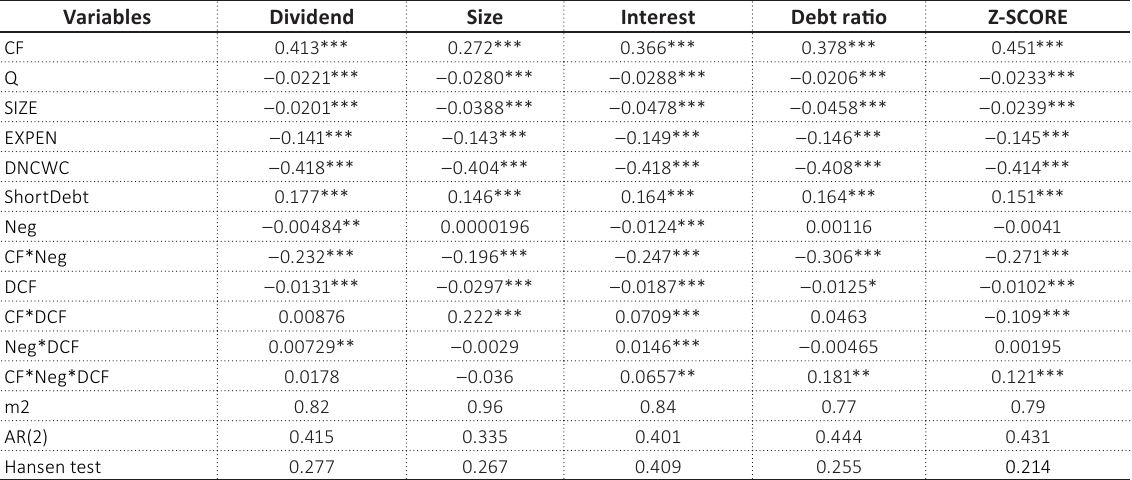
Table 6. Regression results of model